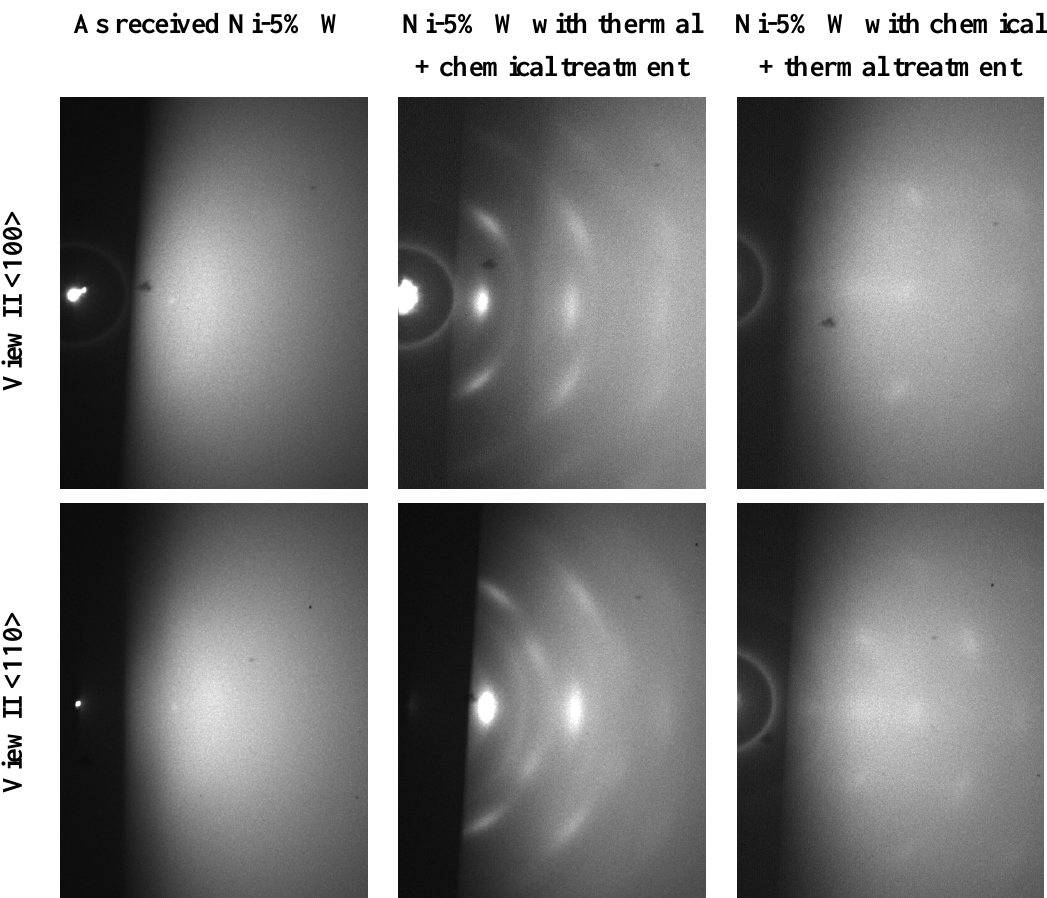
Figure 14. Reflection high energy electron diffraction (RHEED) pattern of uncleaned and differently cleaned Ni-5% W